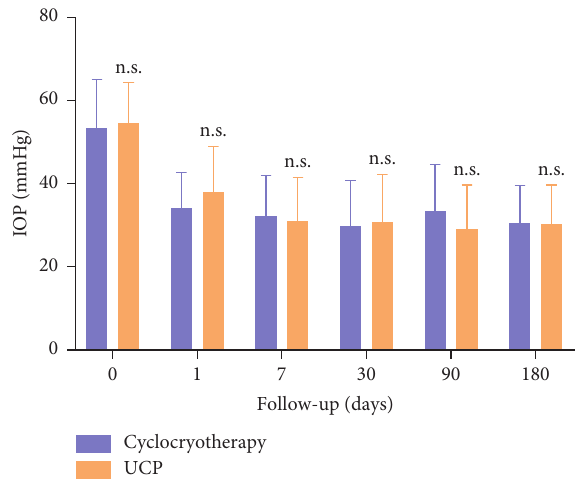
Figure 1: The mean IOP of all patients. Note: ∗ P < 0 . 001; ∗∗ P < 0 . 01; ∗∗∗ P < 0 . 05; n.s. no statistical significance. Table 3: Pain assessment before operation and during follow-up in the patients.